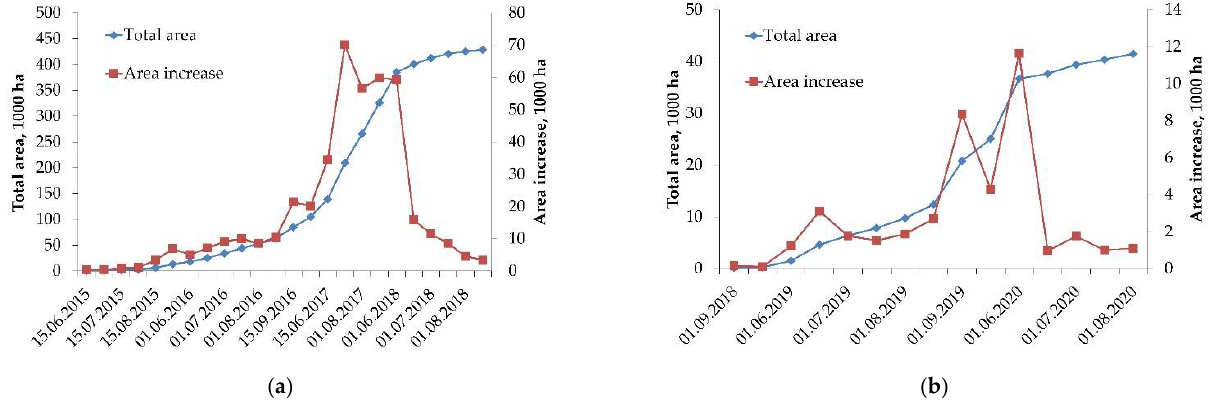
Figure 2. The dynamics of area disturbed by silk moth in EnP ( a ) and in IrP ( b ).